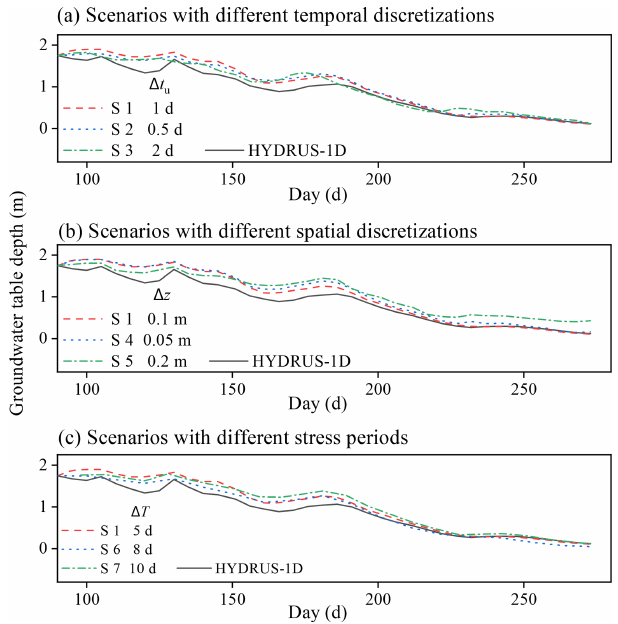
Figure 7. The influence of (a) temporal and (b) spatial discretiza- tion and (c) stress period on simulation